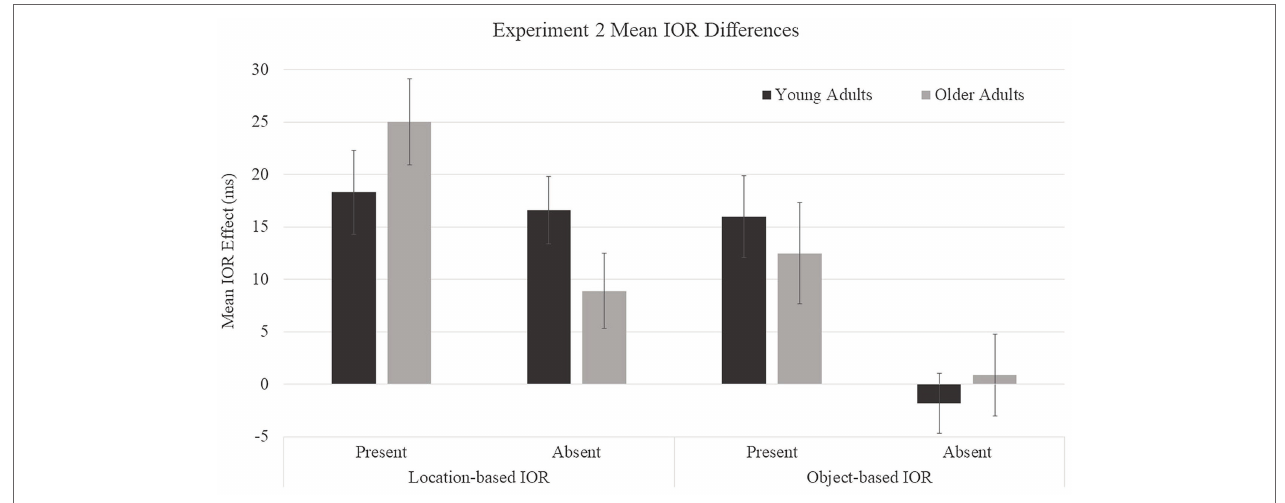
FIGURE 5 | Mean IOR difference scores for young and older adults in Experiment 2. Location-based IOR was calculated by subtracting the average of cued-object and uncued-equal condition RTs from cued-location RTs. Object-based IOR was calculated by subtracting the uncued-equal condition RTs from the cued-object condition RTs. Error bars represent one standard error.